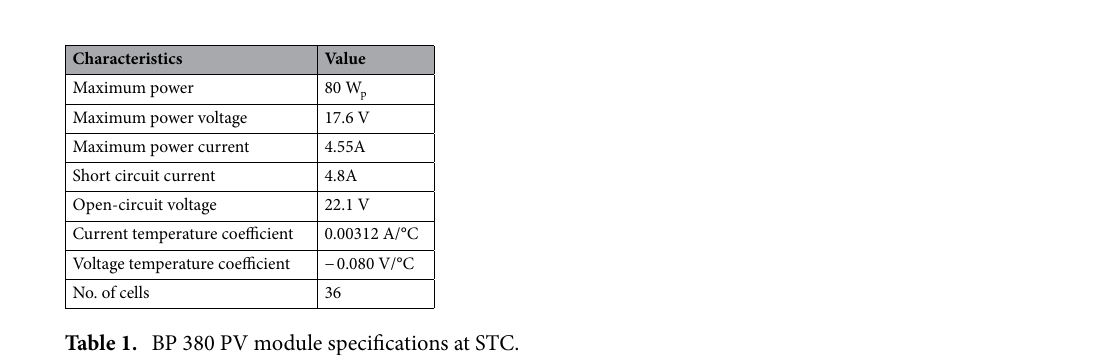
Table 1. BP 380 PV module specifications at